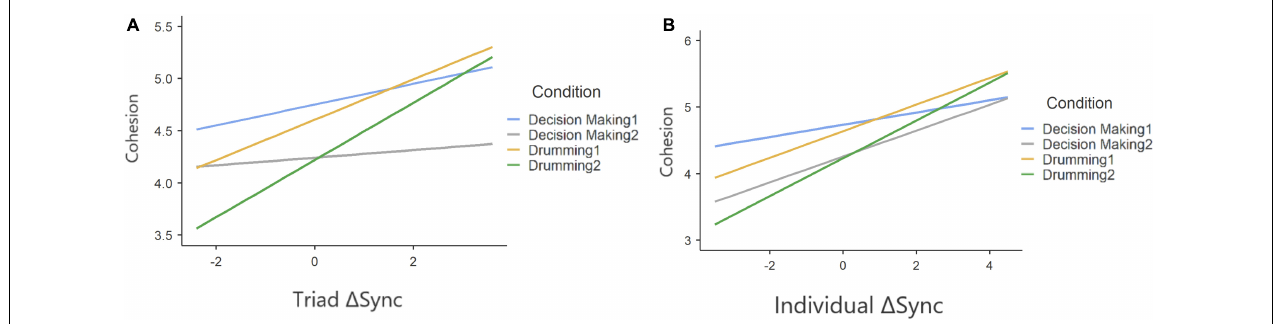
FIGURE 7 | Two-way interaction plot, based on a random slopes and random intercept mixed model, predicting cohesion from (cid:49) Sync on triad level (A) and individual level (B) and on under different conditions (plotted as different colors). The positive correlations indicate that a positive change in IBI synchrony, from baseline to engagement in a group activity, predicts a stronger sense of cohesion among group members.